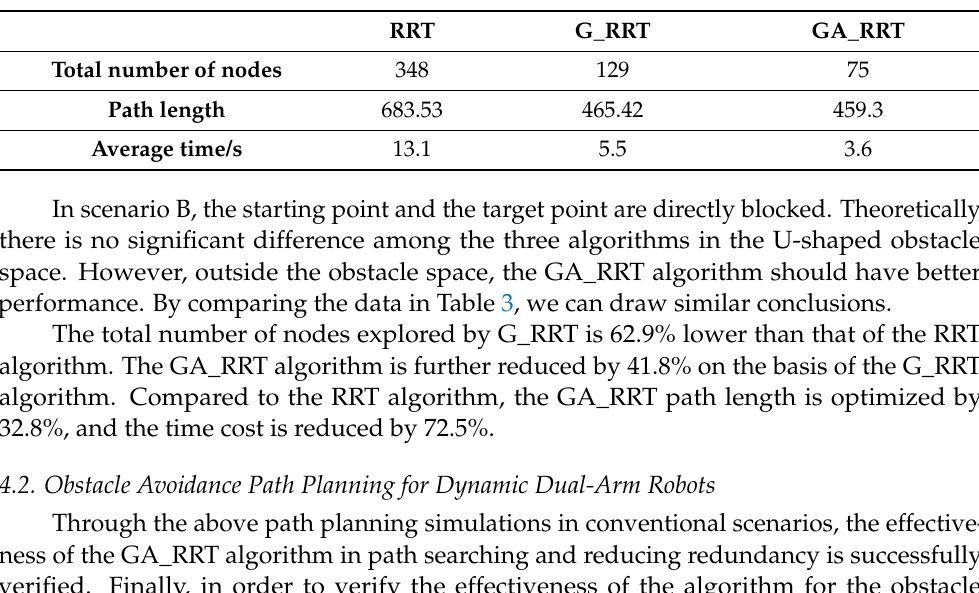
Table 3. The average experimental data for Scenario